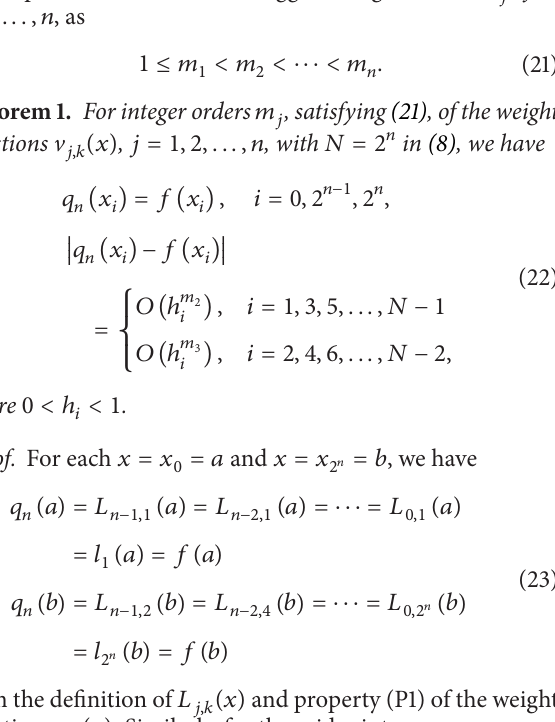
the range between interpolation nodes. For large 𝑗 (i.e., for the large subintervals), higher orders are required to prevent loss of the accuracy at the nodes except the endpoints and the midpoint of the subinterval. Thus, for practical performance of the presented method, we suggest integer orders 𝑚 𝑗 , 𝑗 = 1 , 2 , . . . , 𝑛 ,